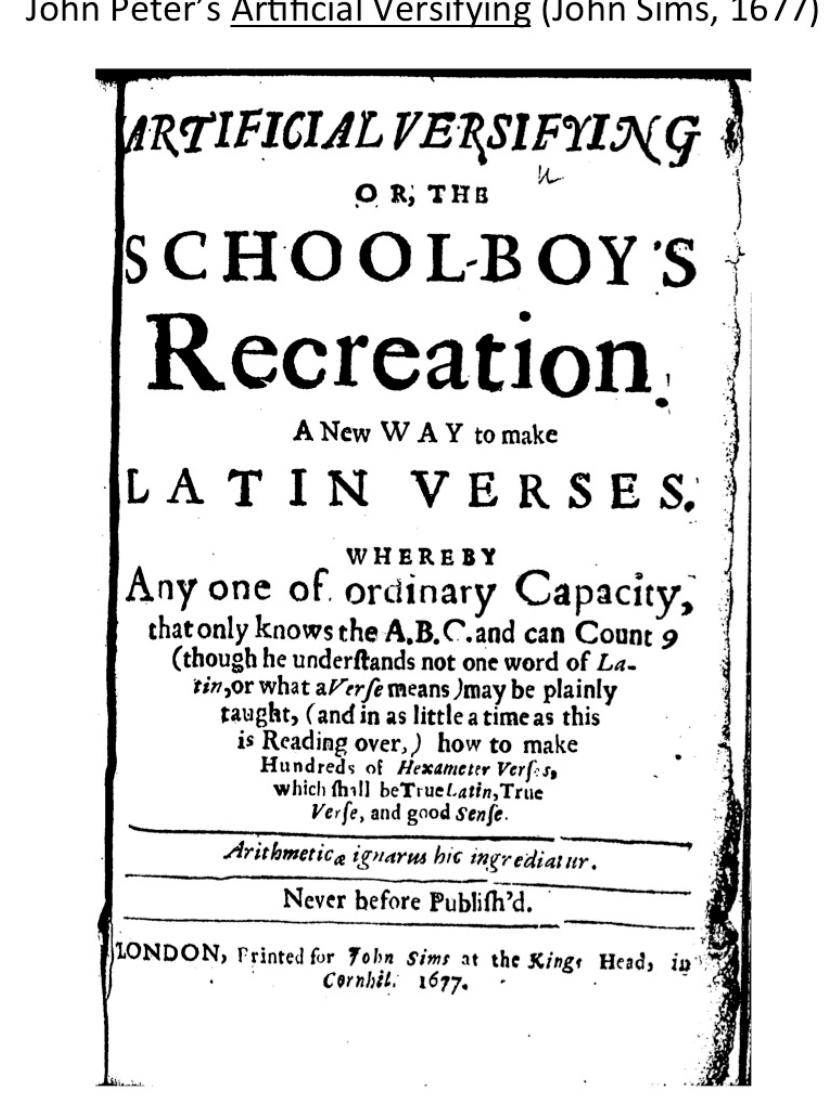
Figure 4. Title page from John Peter’s Artificial Versifying (John Sims, 1677).